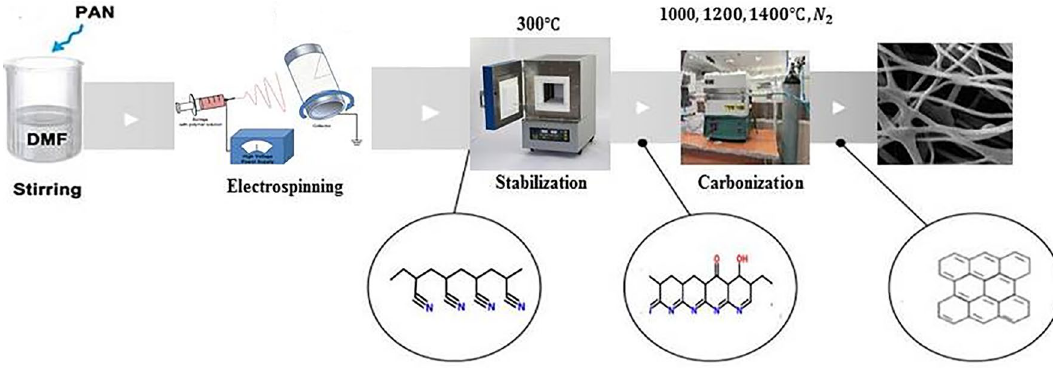
Figure 1. Schematic of the preparation process of carbon